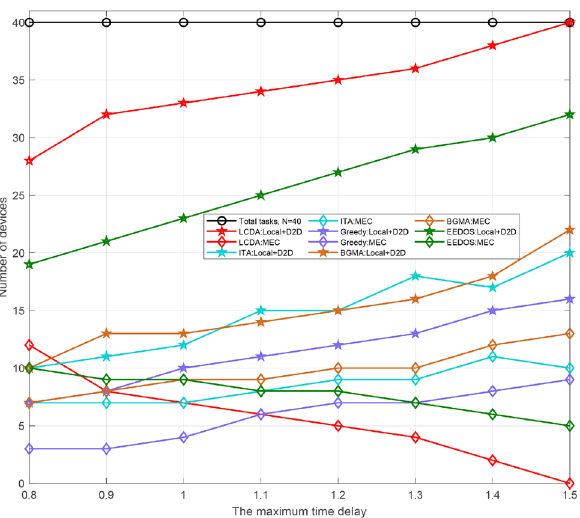
Figure 9. The number of devices versus the maximum time delay of different modes (N = 40).